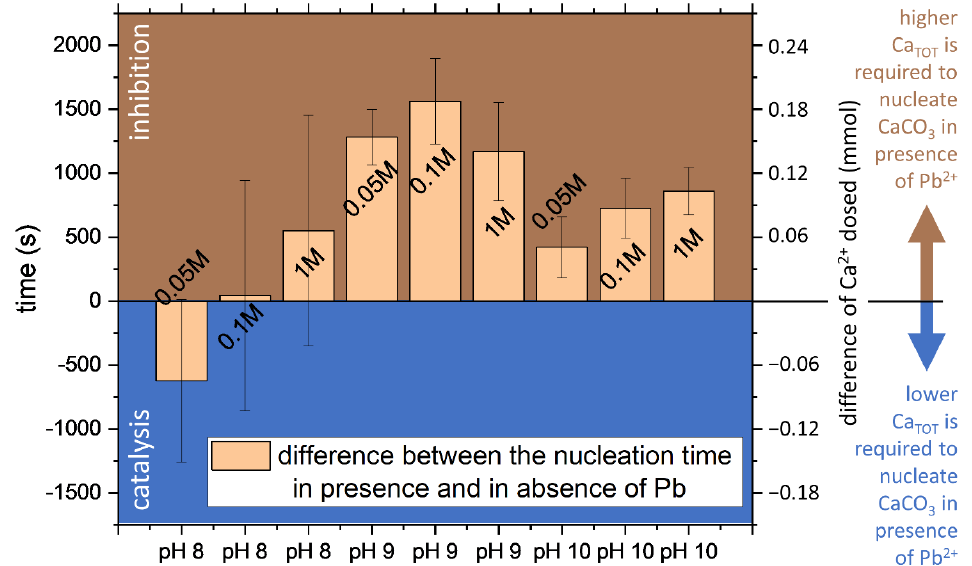
Figure 6. The effect of Pb 2+ on the nucleation of calcium carbonate is reported as the time difference between the detection of nucleation in presence of Pb 2+ minus the induction time observed in absence of Pb 2+ . The values for each experiment correspond to the average of the CaISE, Optrode, PbISE (only in the Pb-bearing experiments) and replicas; the errors are the standard deviations. The labels on the column correspond to the approximate ionic strength.